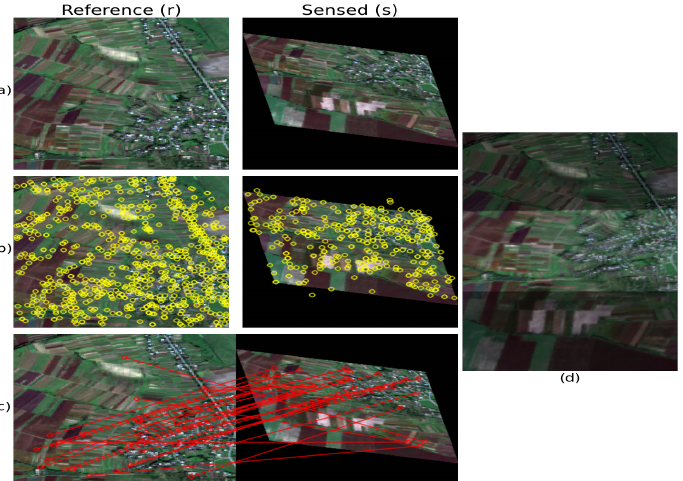
Figure 1. Step-by-step example of optical-optical image matching. ( a ) two optical images; ( b ) features detected by the SIFT descriptor on each image separately; ( c ) features are matched between the two images after evaluating the feature correspondence; ( d ) affine correction and image alignment. The image is taken from the SEN1-2 dataset [7], which is a benchmark dataset for SAR-optimal co-registration, sampled around the world and in all meteorological seasons. Images are acquired from Sentinel-1 (SAR) and Sentinel-2 (optical) with a 10 m/pixel